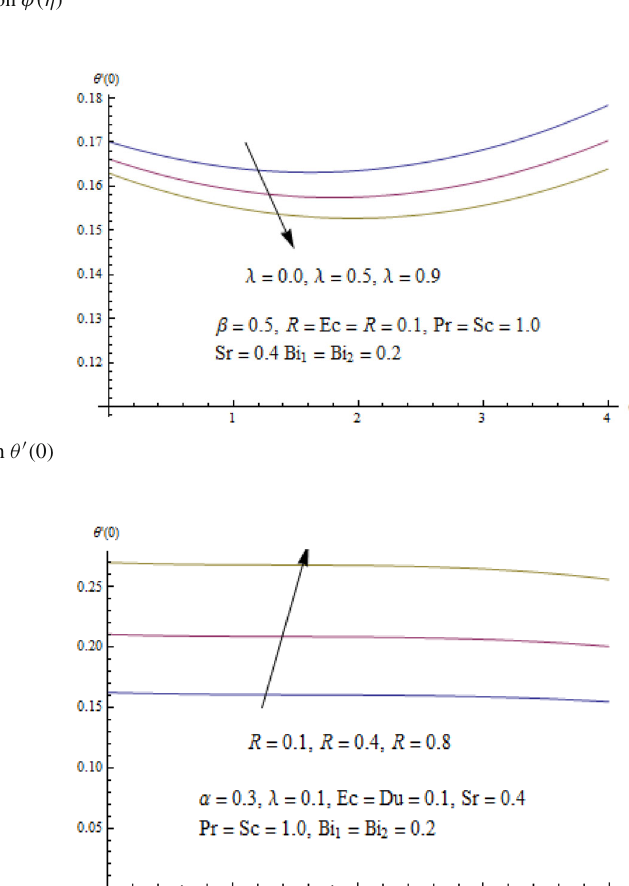
Fig. 25 Impact of Sc on φ(η)